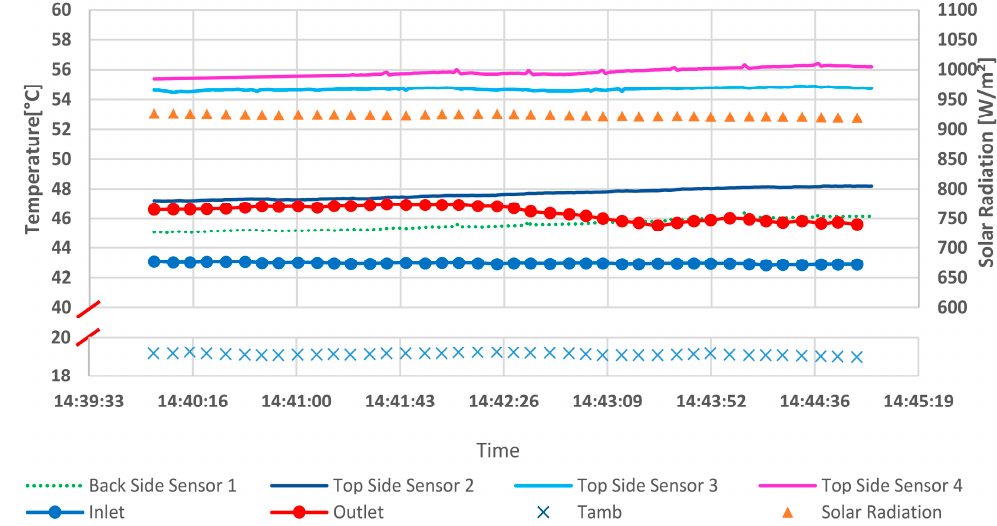
Figure 11. Measurement B: layers, water and ambient temperatures and solar radiation. The flow rate of measurement: 1 L/min.